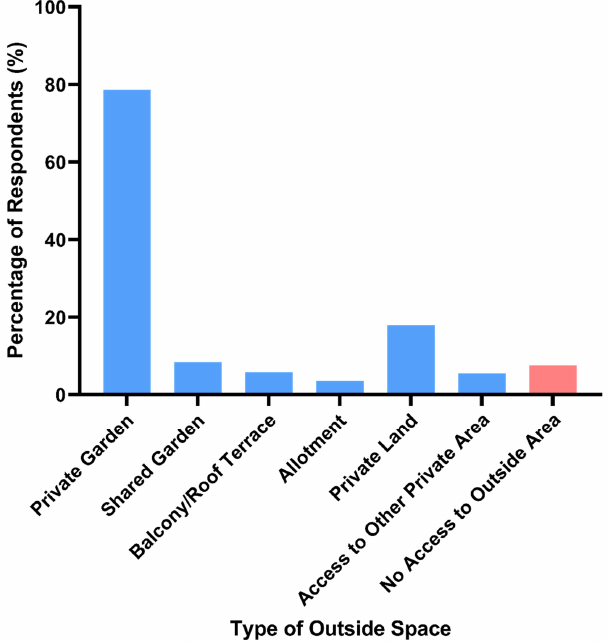
Figure 2. Percentage of respondents with access to different types of outside space, including those reporting to have no access to an outside area. The frequency that respondents went for walks differed significantly between reported levels pre-lockdown, during lockdown, and post-lockdown ( ꭓ 22 = 59.358, p ≤ 0.001; Table 1). Dunn post-hoc tests, with a Bonferroni correction, showed that walking frequency increased significantly during ( p ≤ 0.001) and post-lockdown ( p = 0.005), in comparison to pre-lockdown levels. Table 1. Frequency respondents reported going for walks before, during, and after lockdown.